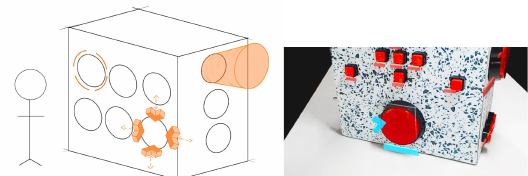
Fig 8. Left: Design options considered for visual annotations and highlighting. Right: Animated arrow shows the button of interest and direction of movement.